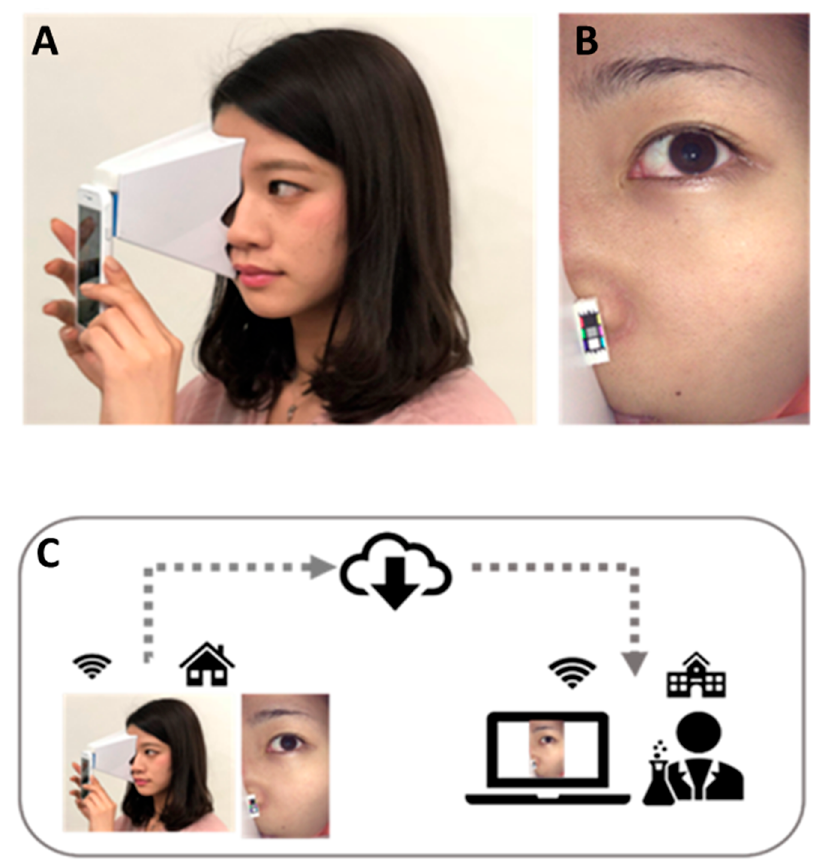
Figure 1. eMR Pro self-guided facial imaging system. The subjects took facial images using their own smartphones with the plastic face attachment ( A ). The facial images ( B ) were then sent to the eMR Pro server ( C